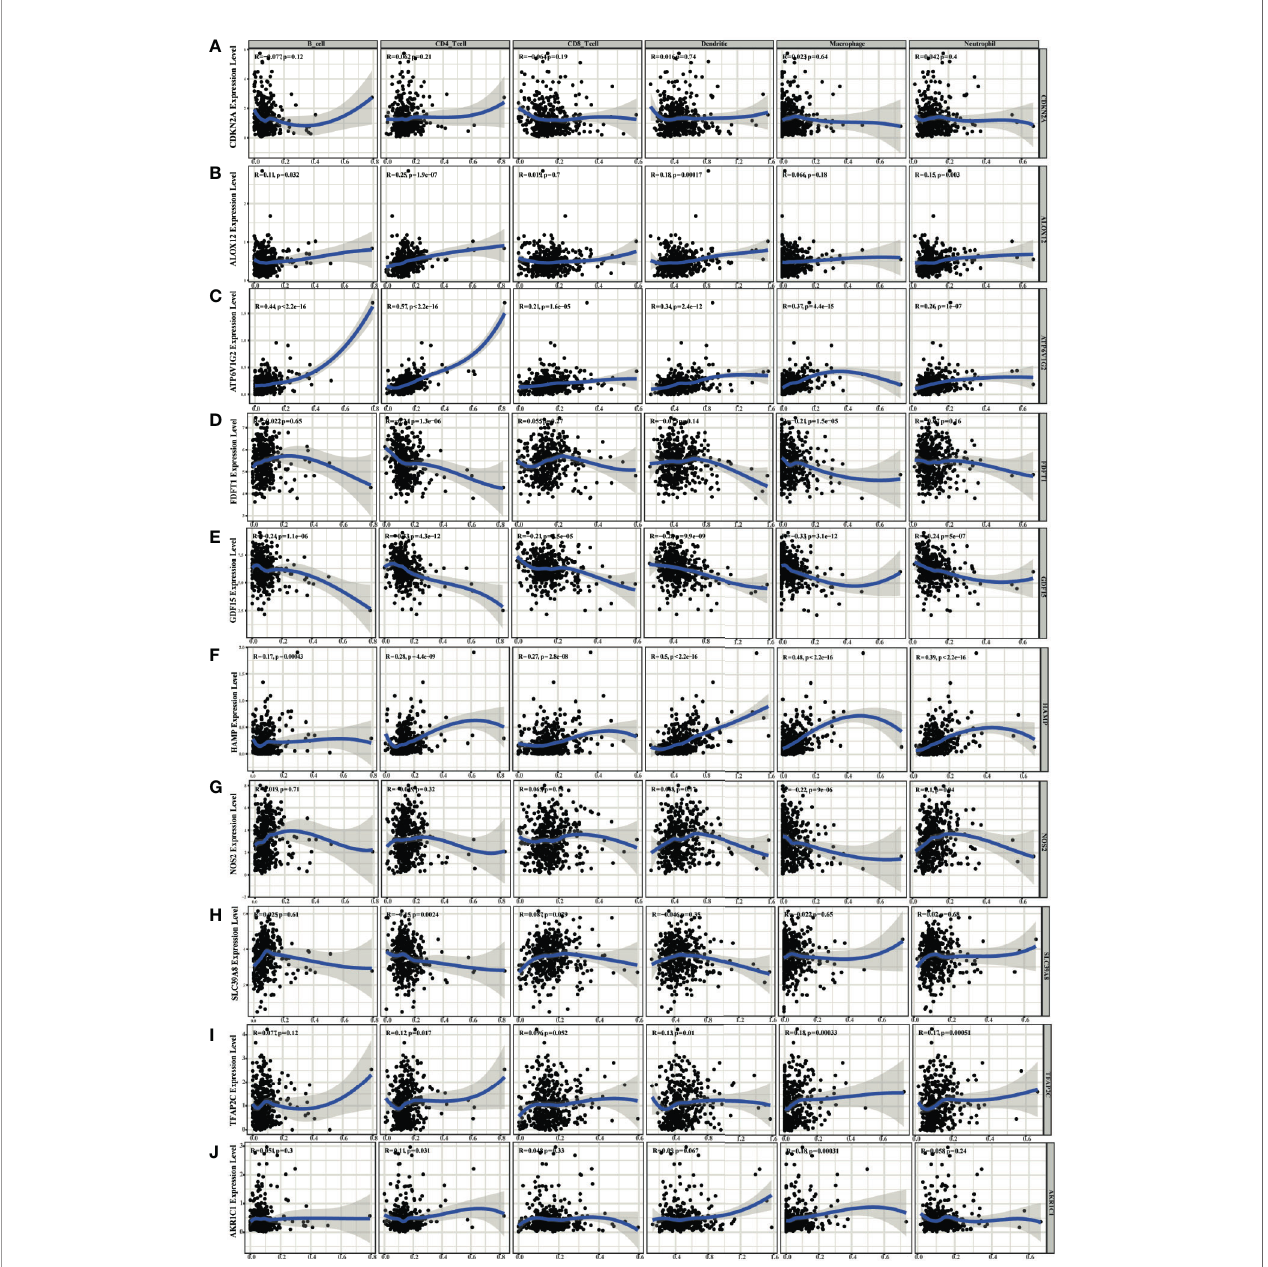
FIGURE 11 | The diagrams of the correlation analysis between CDKN2A (A) , ALOX12 (B) , ATP6V1G2 (C) , FDFT1 (D) , GDF15 (E) , HAMP (F) , NOS2 (G) , SLC39A8 (H) , TFAP2C (I) , AKR1C1 (J) and the immune in fi ltration level in the TCGA